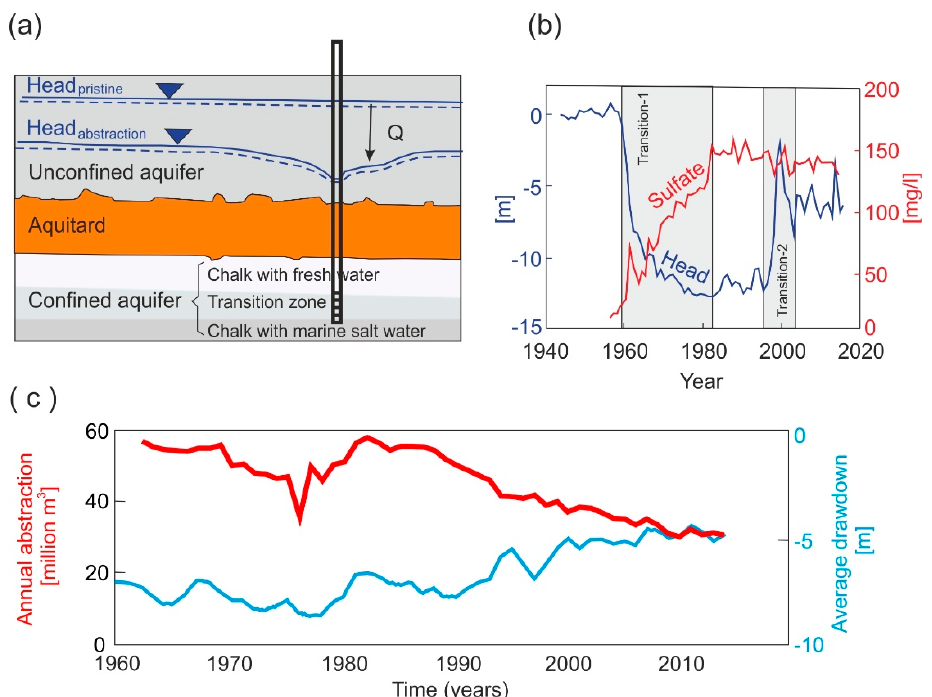
Figure 3. Case study of a set of confined coastal aquifers around Copenhagen (Denmark) (adapted from [8]). ( a ) The confined aquifer are generally formed by an upper layer of chalk with freshwater, an intermediate layer of transition zone with Mg and NaCl and a lower layer of Chalk with marine salt water. ( b ) Potentiometric heads from 1940 until 2014 experienced a 2–14 m decrease in the nearby potentiometric surface compared to the pre-pumping potentiometric surface recordings, meanwhile sulphate concentrations increased from less than 10 mg/l to around 140 mg/l after the maximum extraction period, compared to the earliest water quality parameters. ( c ) Total extraction since 1962 and the average dra-down at the 28 well fields. Note from 1990, the decrease in annual extraction could be modeled as an exponential decay function.